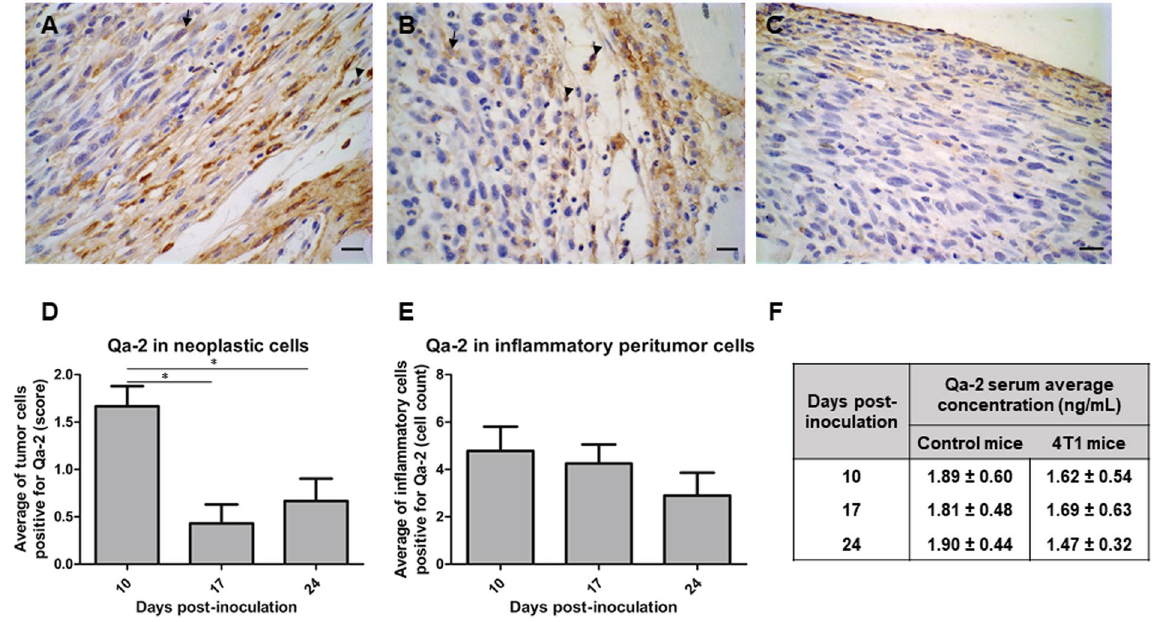
Figure 1. Qa-2 expression decreases during tumor growth. ( A – C ) Immunohistochemical detection of Qa-2 in 4T1-induced tumors at 10 ( A ), 17 ( B ) and 24 ( C ) days post-inoculation. Examples of stained tumor cells and peritumor inflammatory cells are indicated by arrows and arrowheads, respectively. Groups of mice (n = 15) were inoculated i.d./s.c. with 10 6 cells into the left flank. Bars, 20 μ m. ( D , E ) Estimation of neoplastic ( D ) and peritumor inflammatory ( E ) cells stained for Qa-2. Values represent the average number of tumor cells stained for Qa-2 determined in 15 fields. A number of 5 tumors per each post-injection time were evaluated. Asterisk indicates statistically significant difference ( * p < 0.05). ( F ) The concentration of soluble Qa-2 in the sera of mice bearing 4T1 tumors and control mice without tumors at different days post-injection, as determined by ELISA. Values represent the average of 5 mice per group at each post-inoculation